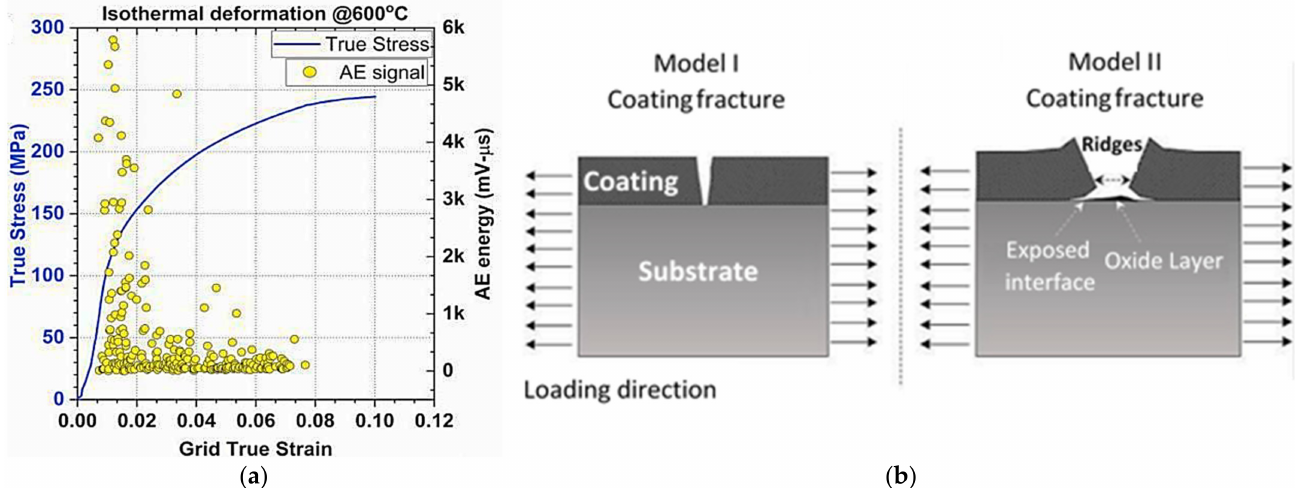
Figure 11. ( a ) Determined stress–strain curve and AE activity of AlSi-coated PHS under tensile deformation at 600 ◦ C; ( b ) schematic representing fracture types of coating mode I (opening) and mode II (interfacial)